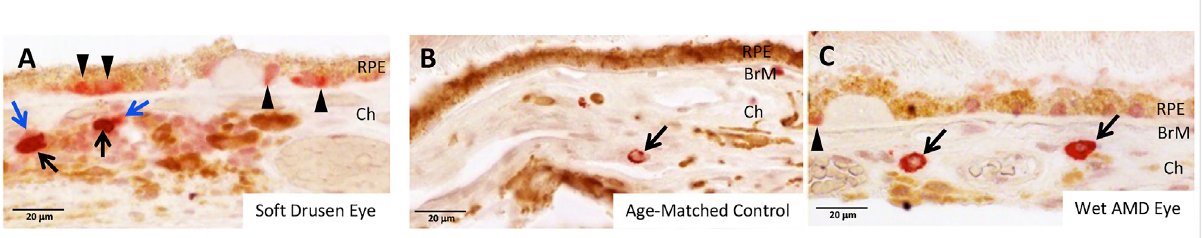
FIGURE 2 Retinal Pigment Epithelium (RPE) and Choroid (Ch) demonstrate stronger GrB immunoreactivity (red AEC, arrows and arrowheads) in soft drusen eyes (A) compared to age-matched control eyes (B) . GrB is also stronger in the choroid of wet AMD eyes (C) compared to age-matched controls (B) . Blue arrows indicate degranulated mast cells in choroid. Bruch ’ s membrane (BrM). Adapted from Matsubara et al.,